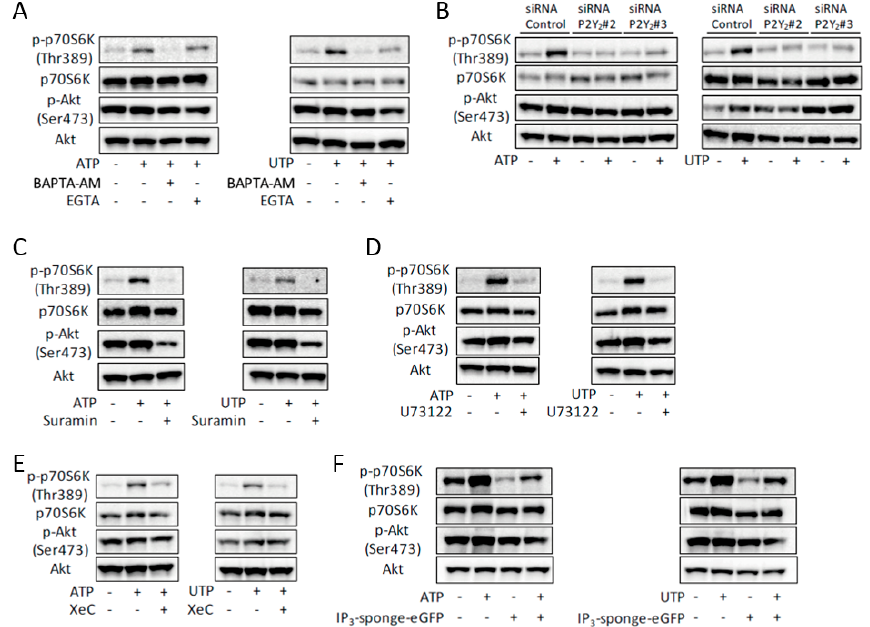
Figure 3. ATP-induced activation of mTOR is mediated by the P2Y 2 receptor and its downstream PLC/IP 3 R pathway in C2C12 myotubes. ( A – E ) Representative Western blots showing the effects of BAPTA-AM or EGTA ( A ), siRNA for the P2Y 2 receptor ( B ), suramin ( C ), U73122 ( D ), XeC ( E ) on ATP- or UTP-induced phosphorylation of p70S6K and Akt ( n = 4). ( F ) ATP- or UTP-induced phosphorylation of p70S6K and Akt in the IP 3 -sponge-overexpressed C2C12 myotubes ( n = 4). The concentration of ATP and UTP was 100 µM and the duration of treatment in all experiments shown in this figure was 30 min.